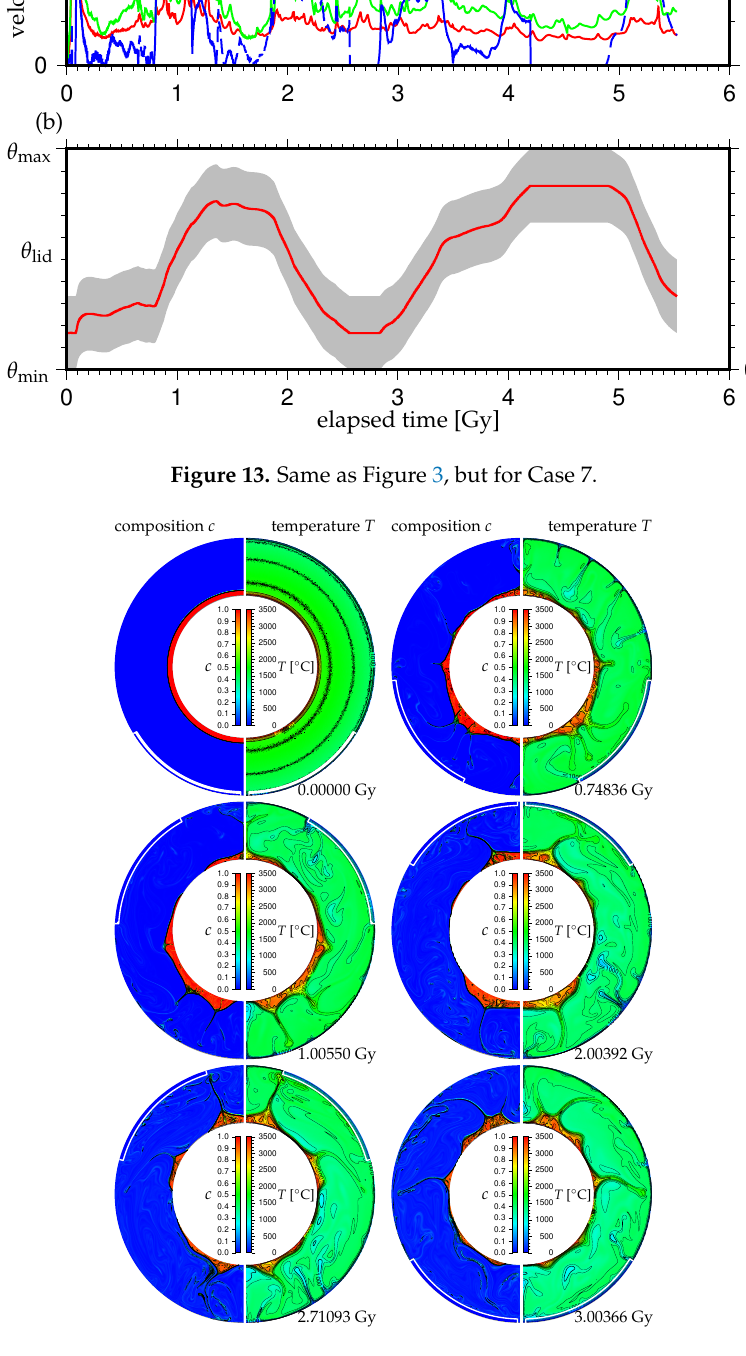
Figure 14. Same as Figure 4, but for Case